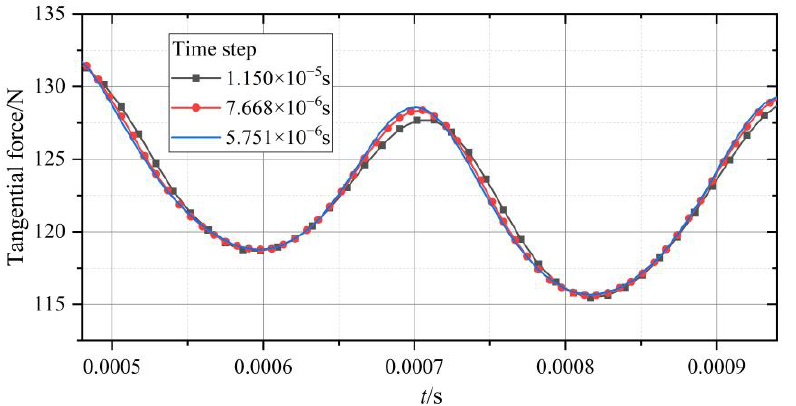
Figure 6. Time step verification.